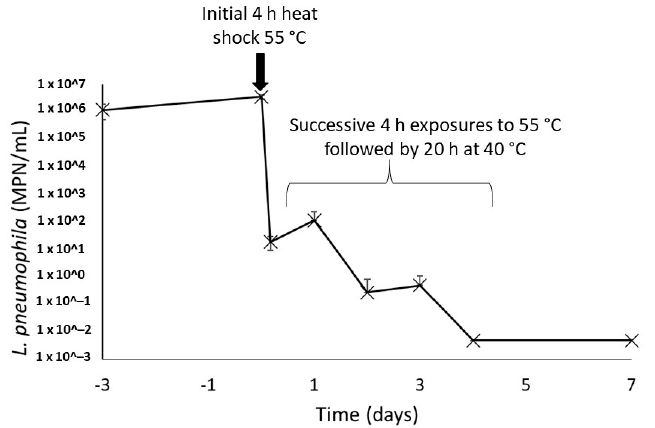
Figure 5. Concentrations of culturable L. pneumophila in water heater sludges after repeated 4 h ther- mal shocks at 55 °C. The concentrations on days 4 and 7 were under the detection limit of the enzy- matic test in all samples, duplicate of each water heater loose deposits.